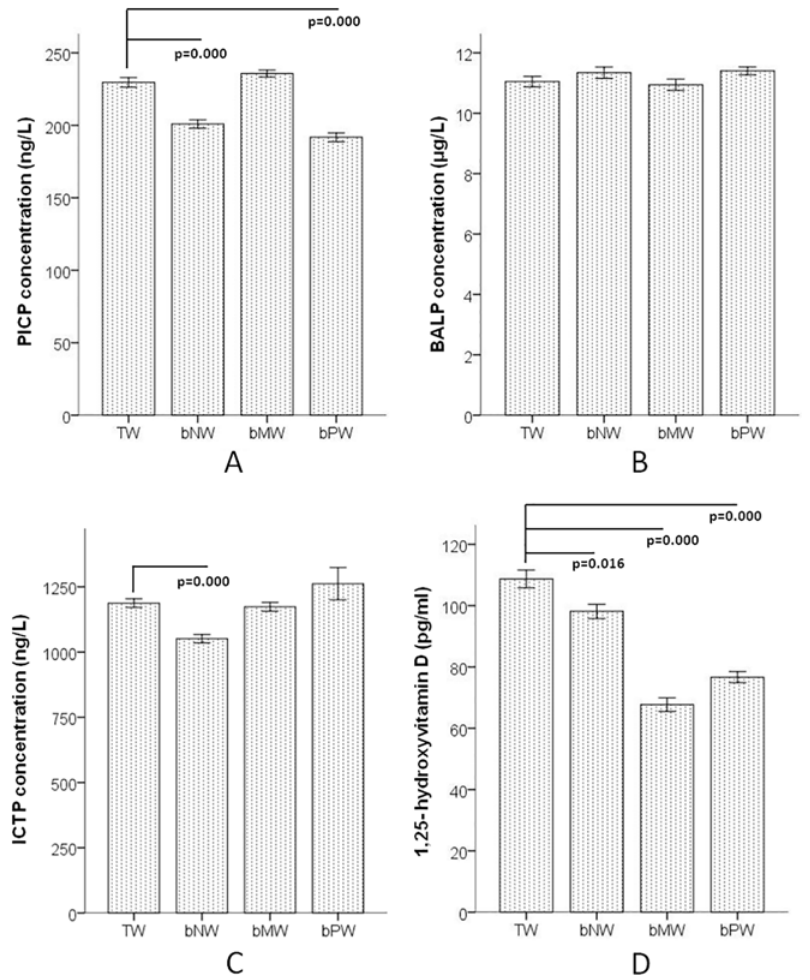
Fig 3. Biochemical indicators of bone metabolism in F2 generation female rats after 3 generations of continuously drinking the 4 water types. A shows the level of PICP, B shows the level of BALP, C shows the level of ICTP and D shows the level of 1,25-dihydroxyvitamin D in serum. TW: Tap water, bNW: bottled natural water, bMW: bottled mineralized water, bPW: bottled purified